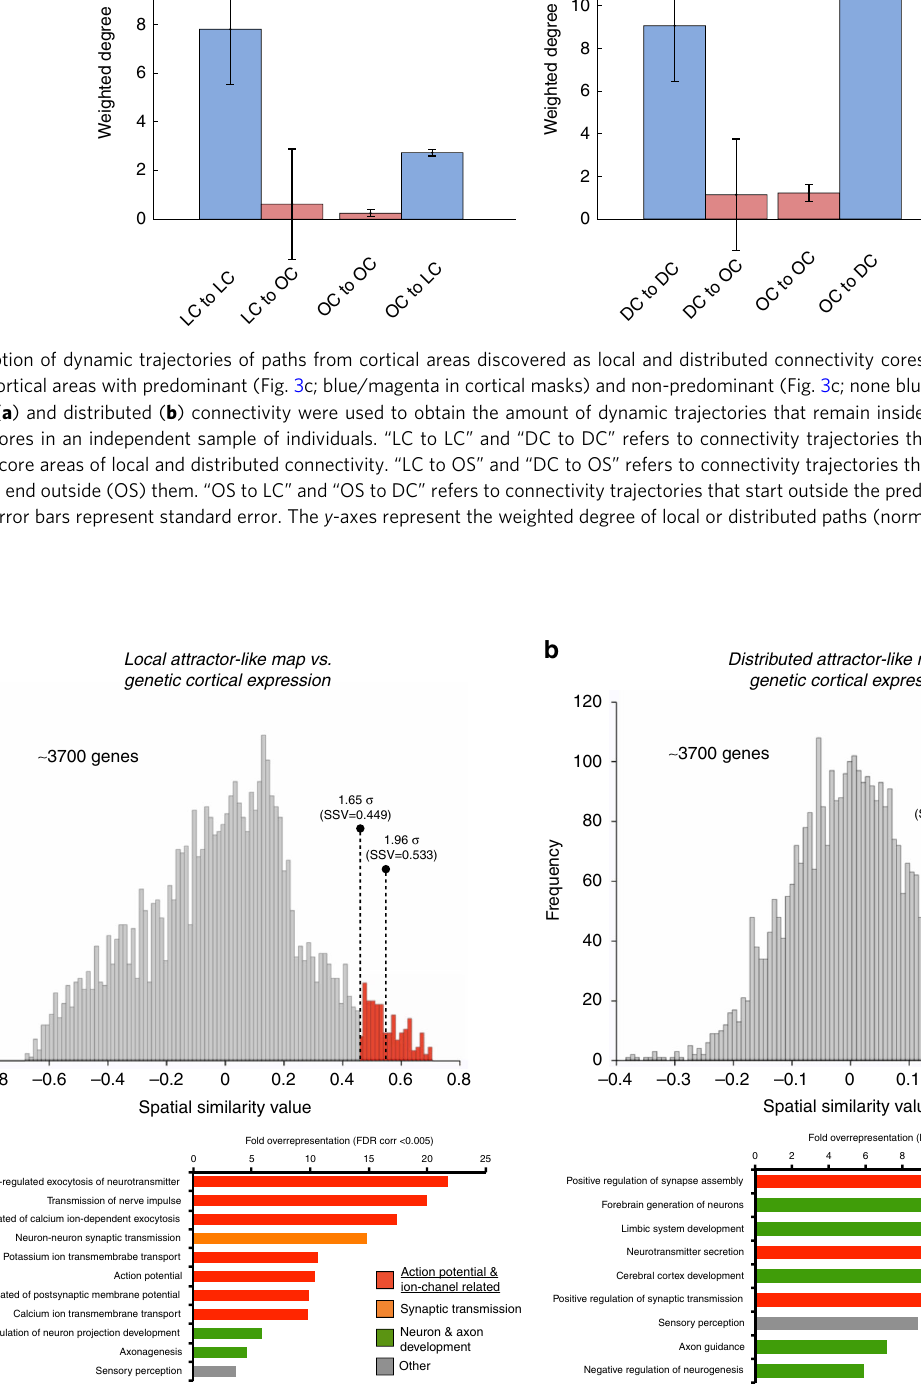
Fig. 5 Histograms represent the distribution of spatial similarity scores between dynamic connectivity maps (local ( a ) and distributed ( b )) and the cortical expression of neuro-related genes (~3700) from the Allen Human Brain Atlas. Two levels of statistical threshold are shown using red bars with dotted lines (>1.65 SD and >1.96 SD). Bar graphs show the FDR-corrected GO overrepresentation analyses of genes with genetic expression spatially related to dynamic connectivity maps (local ( a ) and distributed ( b ))